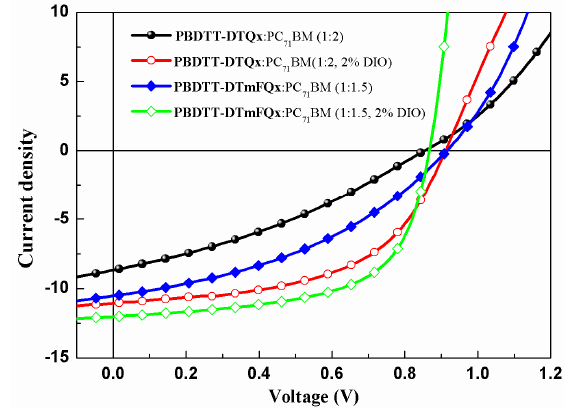
Figure 4. Current density–voltage ( J–V ) curves of the copolymer/PC 71 BM-based polymer solar cells (PSCs) at optimized conditions under illumination of AM 1.5G, 100 mW/cm 2 .